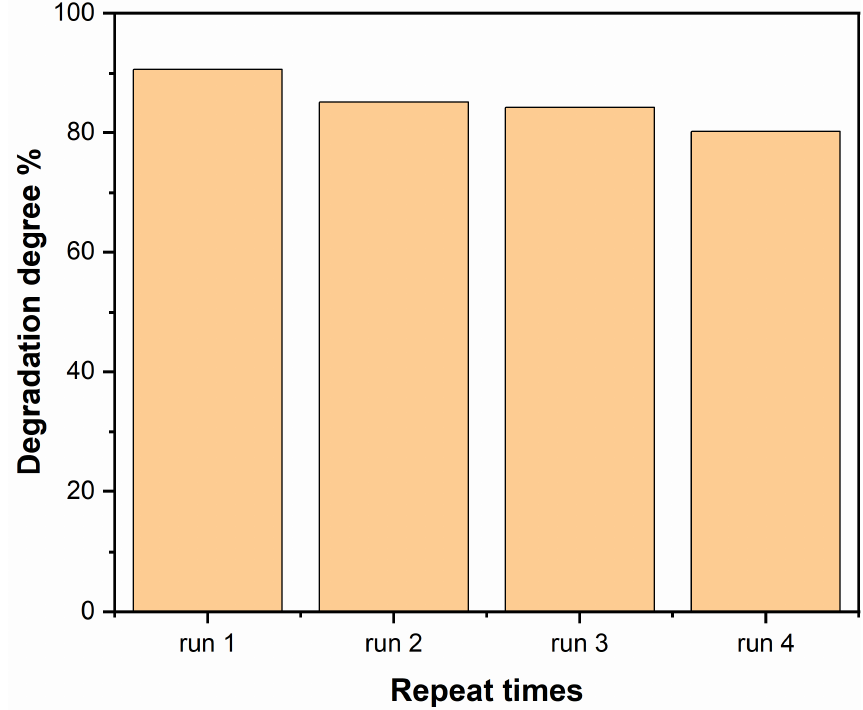
Figure 10. The reuse experiment of 1-ATM photocatalyst for RhB degradation.